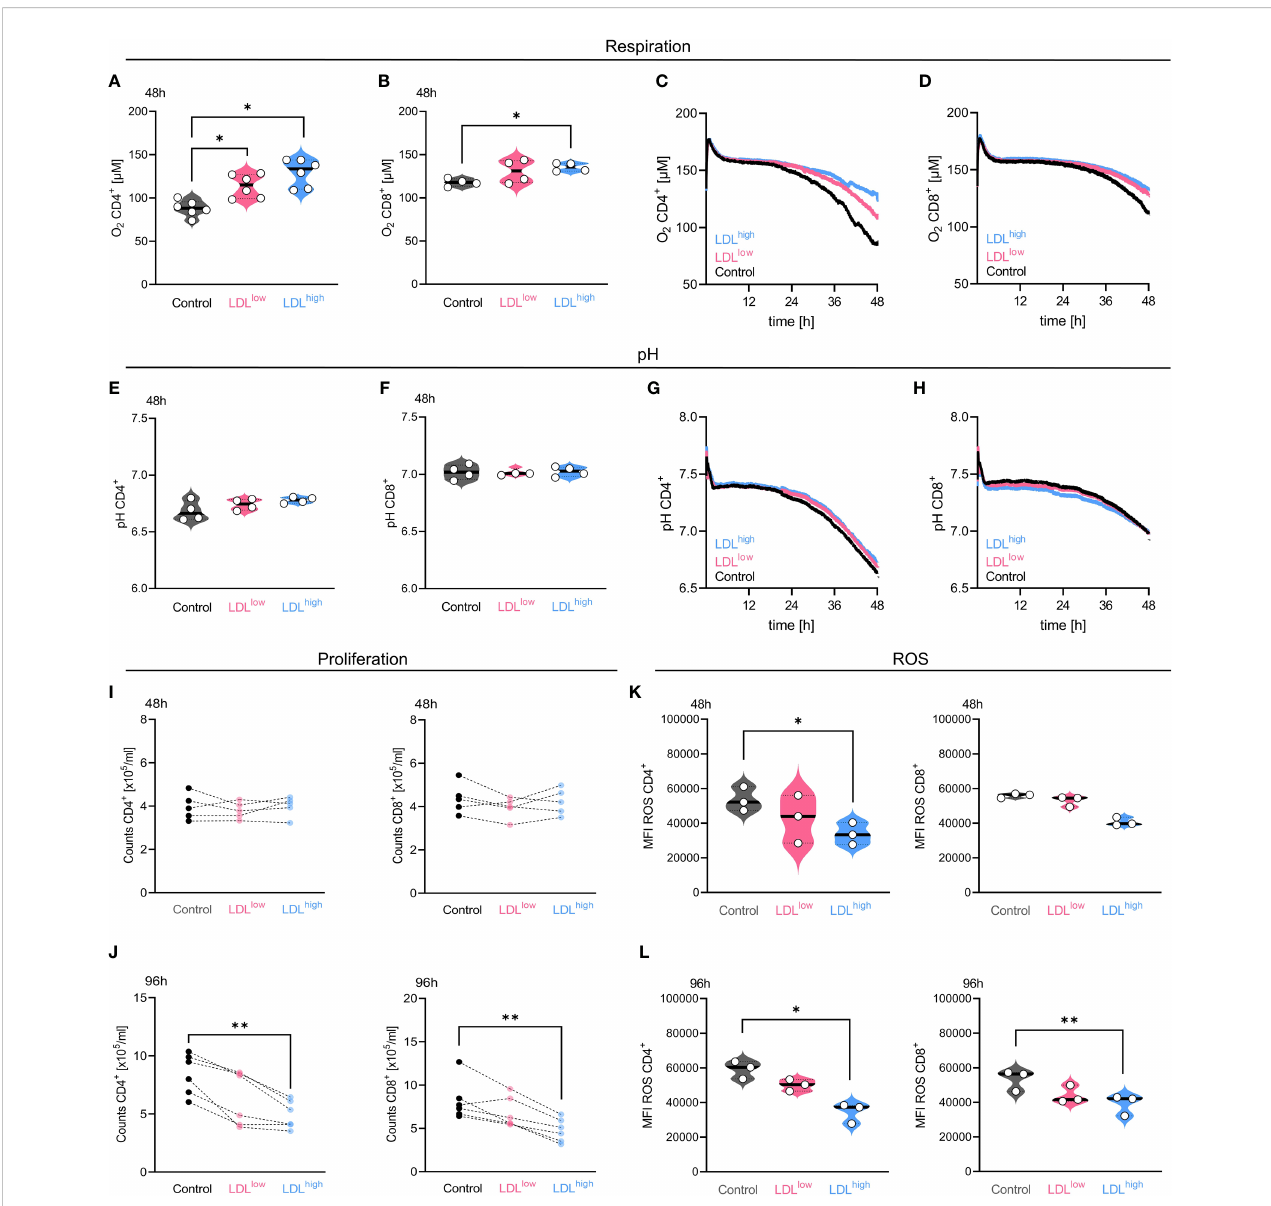
FIGURE 1 In the presence of LDL high , oxygen consumption, cell proliferation and reactive oxygen species (ROS) accumulation were signi fi cantly reduced in both T cell subsets. T cells were freshly isolated and stimulated with anti-CD3/CD28 beads, IL-2 and treated with different LDL dosages (LDL low = 50 µg/ml and LDL high = 200 µg/ml) versus medium control. Respiration: [ (A) CD4 + , (B) CD8 + ] LDL signi fi cantly down-regulated oxygen consumption after 48 h (CD4 + n = 6, CD8 + n = 4) in both T cell subsets. [ (C) CD4 + , (D) CD8 + ] Representative illustration of the detection of oxygen concentration over 48 h in both T cell subsets by PreSens technology. pH : [ (E) CD4 + , (F) CD8 + ] The CD4 subset showed a reduced acidi fi cation in the presence of LDL high by trend, however no signi fi cance. [ (G) CD4 + , (H) CD8 + ] Representative illustration of the pH detection over 48 h in both T cell subsets by PreSens technology Proliferation: [ (I) 48 h, (J) 96 h] Proliferation, shown as counts x 10 5 /ml, was signi fi cantly restrained in both T cell subsets by LDL high after 96 h. ROS : [ (K) 48 h, (L) 96 h]. Accumulation of ROS was signi fi cantly reduced after 48 h and 96 h by LDL high in both T cell subsets (CD8 + 48 h not signi fi